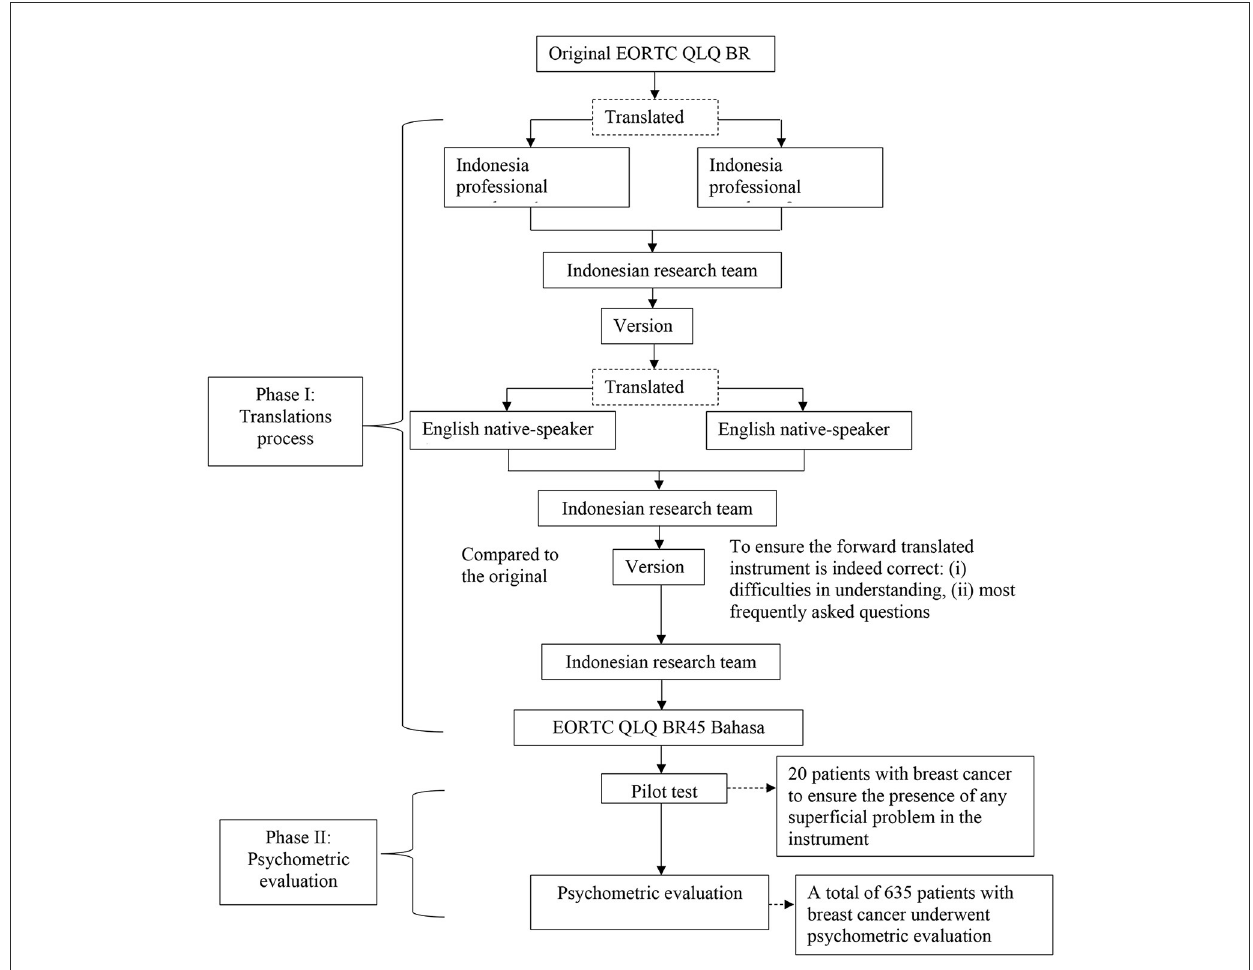
FIGURE1 Multiple standardized process flowchart of this study.